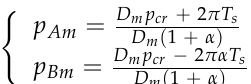
Figure 2. ( a ) Typical configuration of CBV for PCMH system, ( b ) characteristic plot of typical CBV in PCMH system.